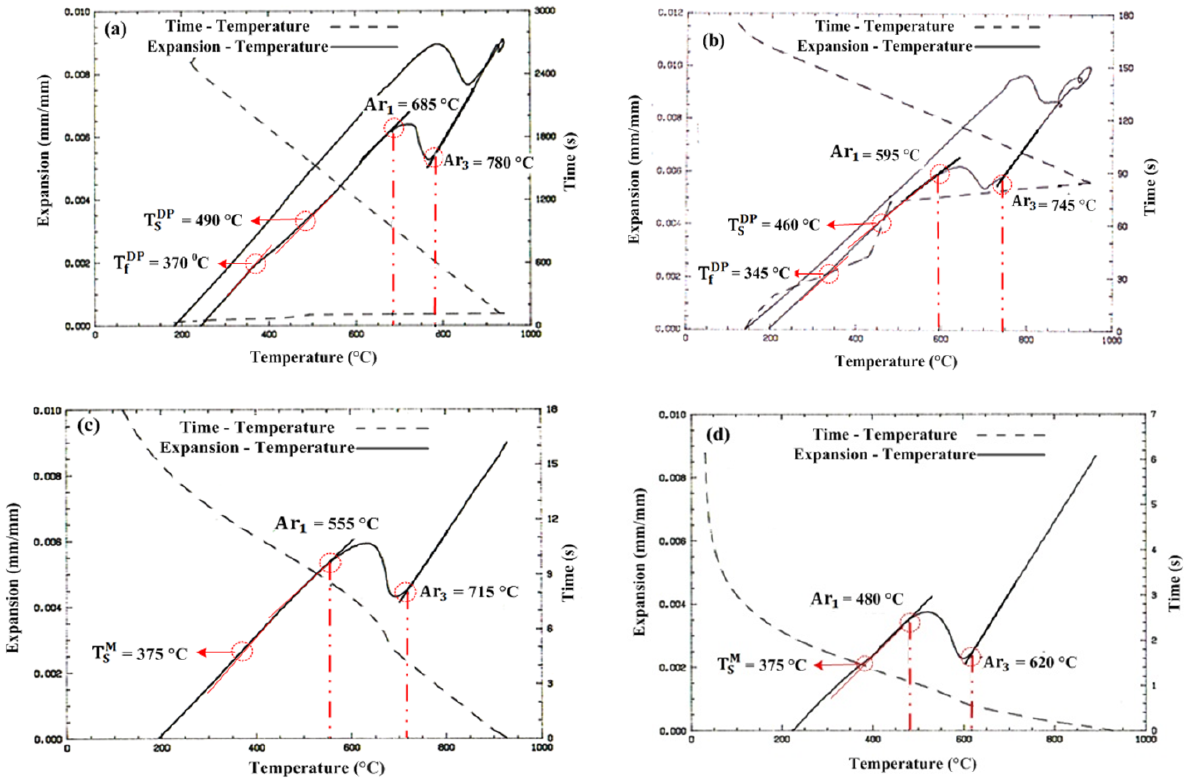
Figure 6: Dilation cooling curves of weld simulated API 5L X-60 pipeline steel at different cooling rates: (a) 0.3; (b) 10; (c) 50; and (d) 360 ∘ C/s. The dashed and solid lines represent Expansion – Time and Expansion – Temperature curves,